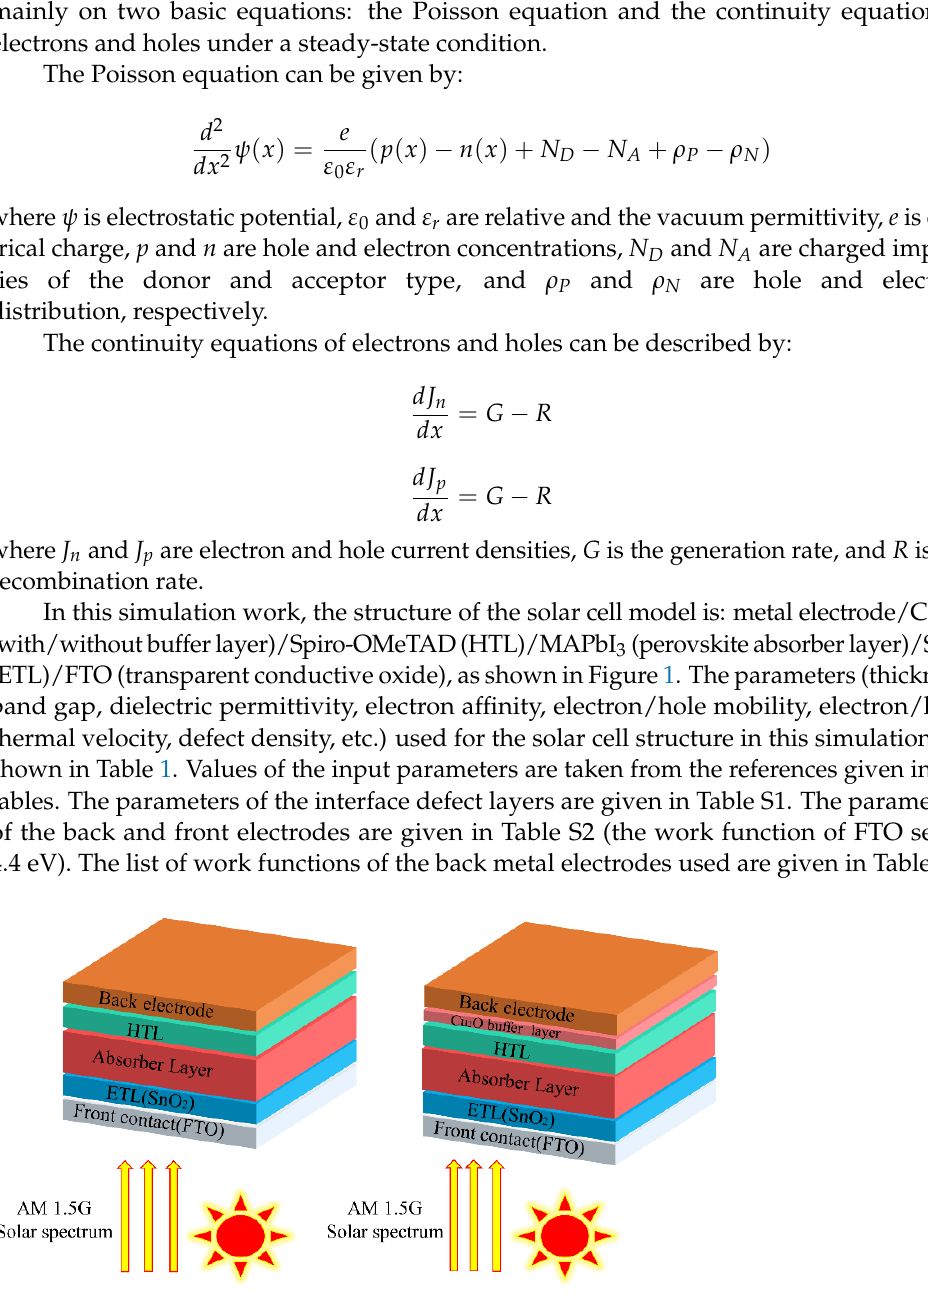
Figure 1. The n-i-p typical perovskite solar cell structure ( left ) and the structure with a Cu 2 O buffer layer ( right ).